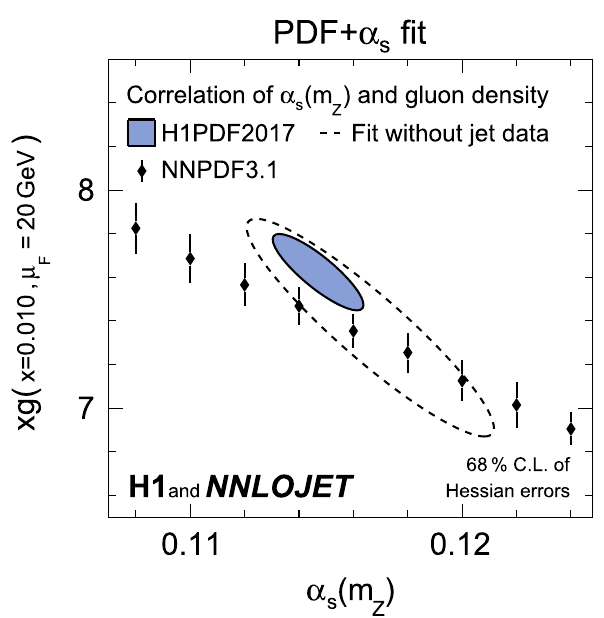
Fig. 17 Error ellipses of Hessian uncertainties at 68% confidence level of α s ( m Z ) and the gluon density xg at μ F = 20GeV and x = 0 . 01 as a result of two different PDF+ α s -fits. The filled ellipse indicates the result of the H1PDF2017[NNLO] fit and the dashed line of a PDF+ α s - fit with jet data excluded. The error ellipses represent the combined effect of experimental and hadronisation uncertainties as described in the text. The diamonds indicate the gluon density of the NNPDF3.1 PDF set for fixed values α PDF s ( m Z